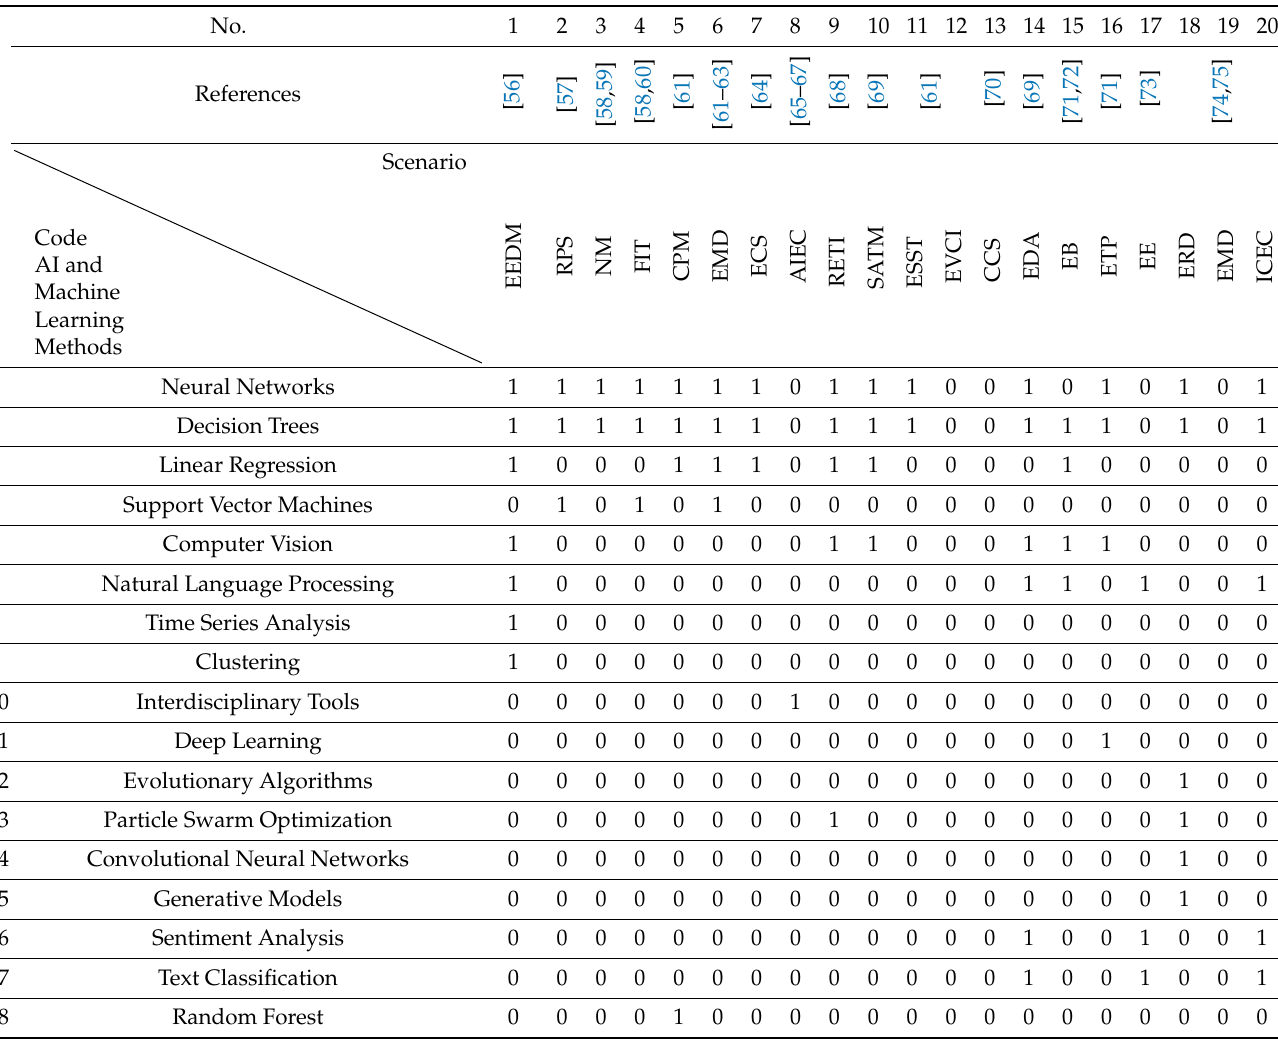
Table 1. The relationship between scenario codes and AI techniques, where 1 indicates that the technique is used in the given scenario and 0 indicates that it is